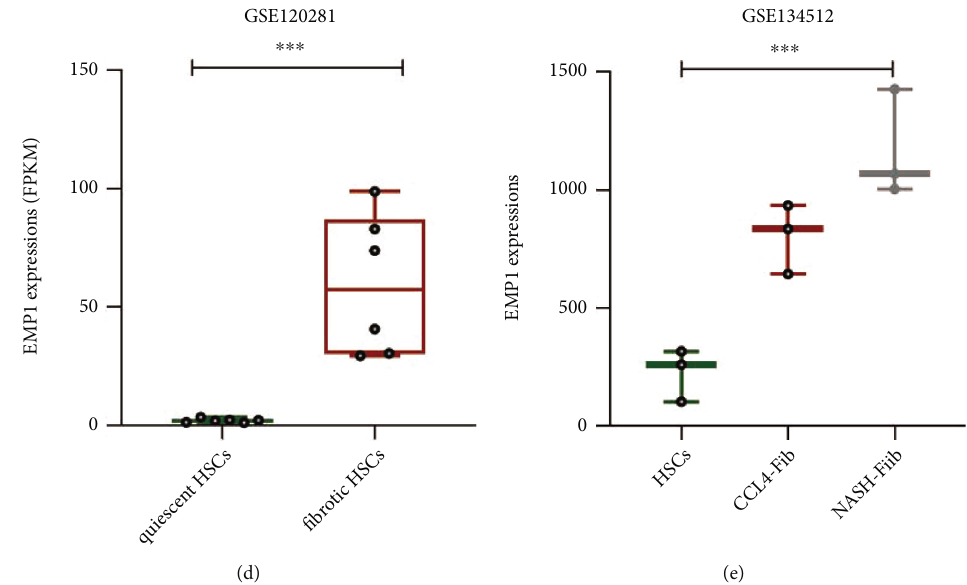
Figure 4: EMP1 is expressed in activated fi brotic hepatic stellate. The cell type atlas given by Protein Atlas (https://www.proteinatlas.org/) validated the expression of EMP1 in liver tissues. (a) Feature plot of EMP1 overlaid with the UMAP projection of liver samples. (b) Bar plot showing the TPM expression of EMP1 across di ff erent cell type clusters including hepatocytes, Ito cells, T cells, Kupfer cells, B cells, and others. (c) Heatmap plot of normalized EMP1 expressions along with other marker genes across the di ff erent cell types in liver tissues. Signi fi cant positive association of EMP1 expression with fi brotic HSCs (GSE120281) (d) and activated fi broblast introduced by either treatment or Western diet-fed NASH model (GSE134512) samples (e). CCl , carbon tetrachloride; EMP1, epithelial membrane CCl 4 4 protein 1; NASH, nonalcoholic steatohepatitis; TPM, transcripts per million; UMAP, Uniform Manifold Approximation and Projection. P < 0 : 05 and *** P < 0 : 01